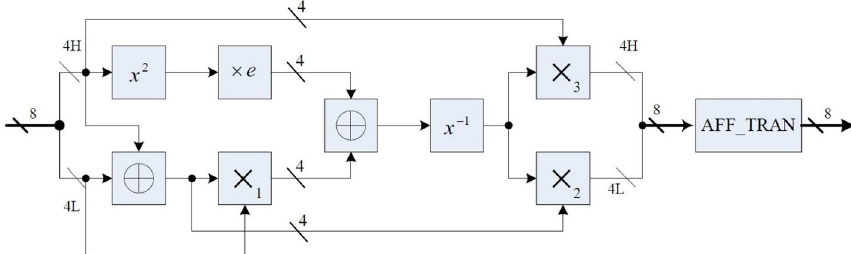
Fig. 7 Subbytes in composite field GF((2 4 ) 2 )